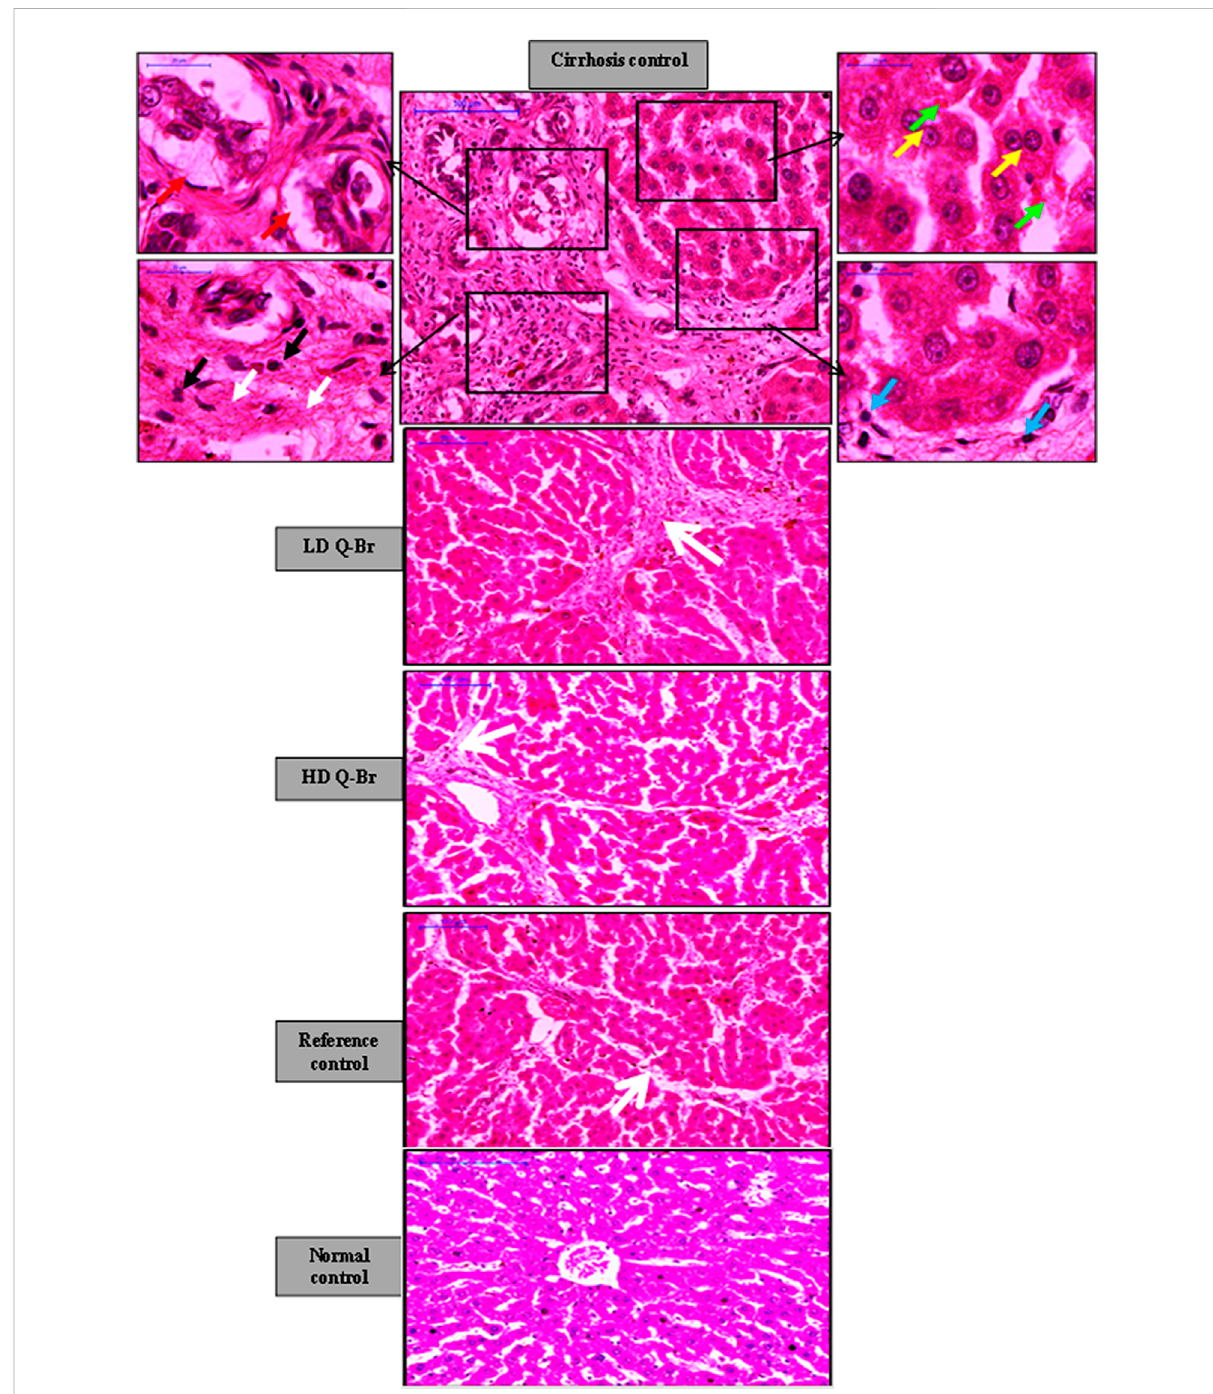
FIGURE 4 Hepatoprotective effect of Q-Br on the liver histpathology of hematoxylin and Eosin (H and E) staining showing gradual improvement in the fi broticstatusoftherats ’ livers.Thecirrhosiscontrolgrouplivertreatedwiththioacetamide(TAA)revealing fi broticseptaeextendingfromthecentral vein (white arrow), intensive mononuclear in fl ammation (blue arrow) and neutrophil in fi ltration (black arrow), bile duct proliferation (red arrow), binucleated (yellow arrow), and apoptotic hepatocytes (green arrow). Signi fi cant gradual reduction in the formation of fi brotic septae, neutrophil in fi ltration along with absence of bile duct proliferation is noticeable from the LD Q-Br (25 mg/kg) to the HD Q-Br (50 mg/kg) to the Silymarin-treated group (50 mg/kg),